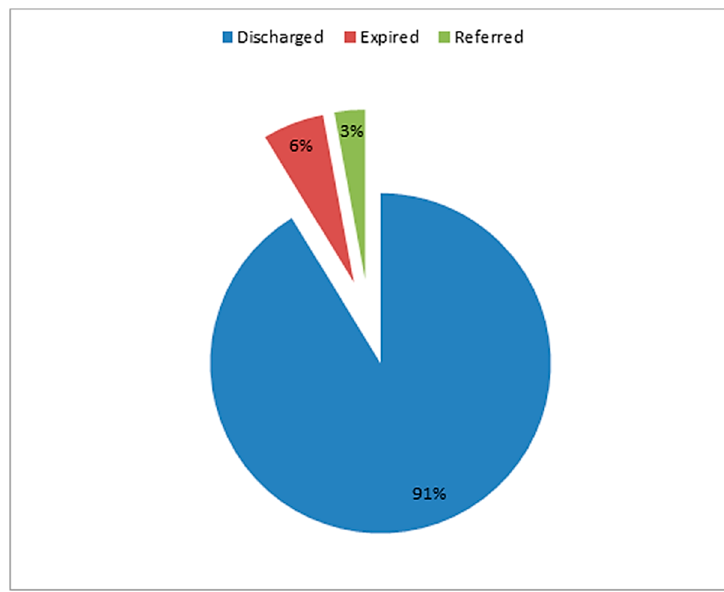
Figure 3. Outcome of total patients admitted in STIDH (N = 860).